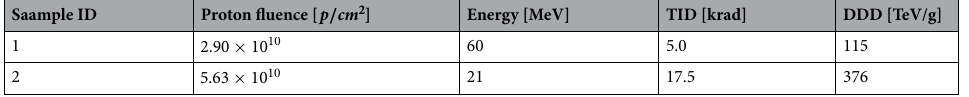
Table 1. Protons delivered to samples and corresponding TID and DDD levels .